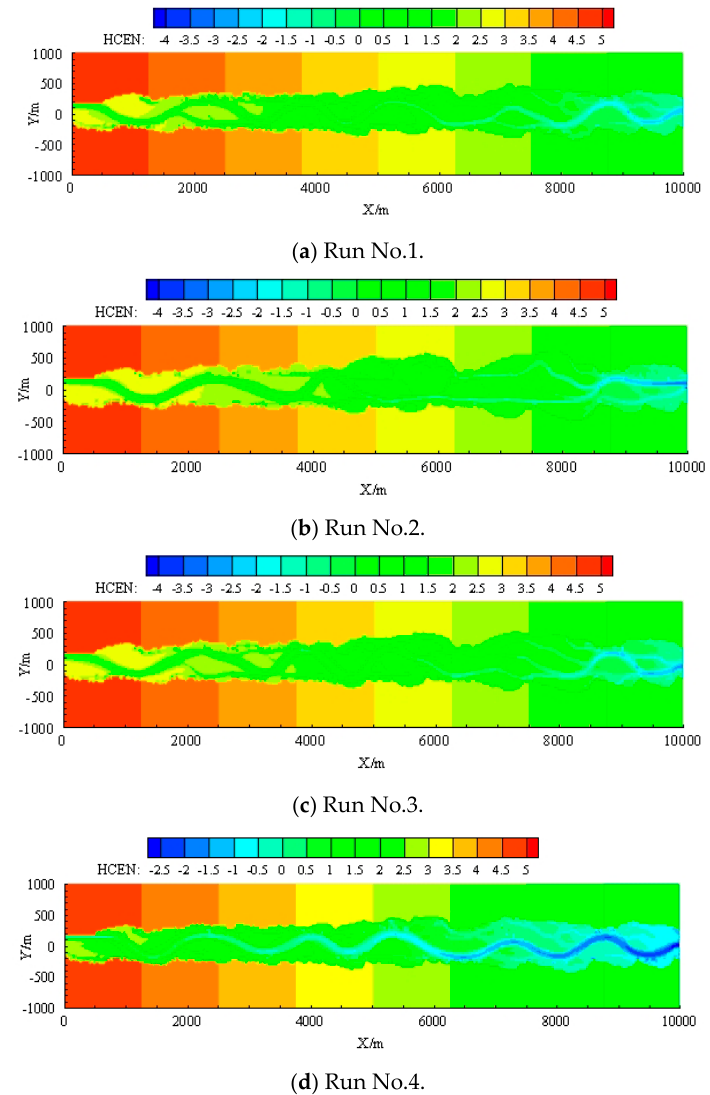
Figure 7. Layout of the experimental channel after 600 days (HCEN: Bed level/m). ( a ) Run No.1; ( b ) Run No.2; ( c ) Run No.3; ( d ) Run No.4.